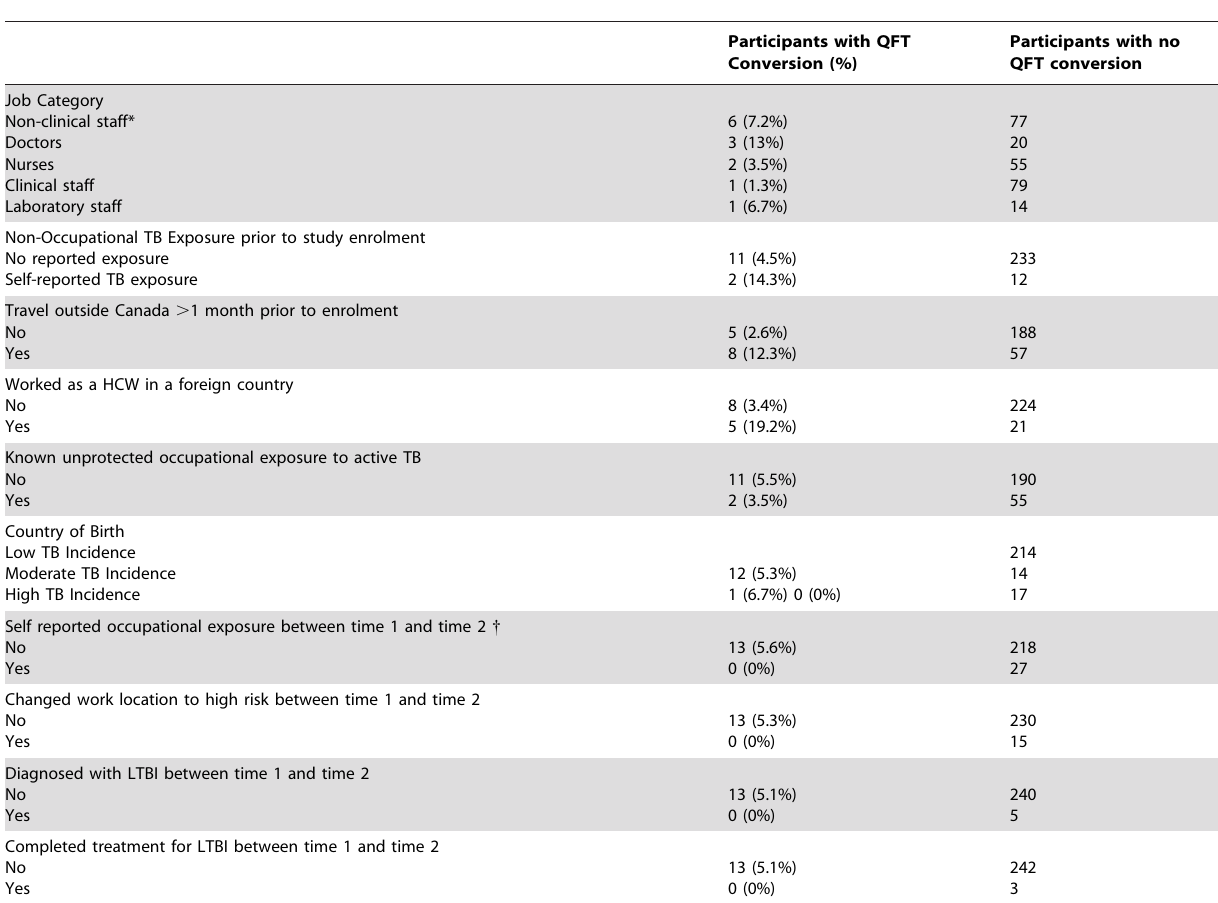
Table 3. Occupational factors associated with QFT Conversion (using manufacturer’s conversion